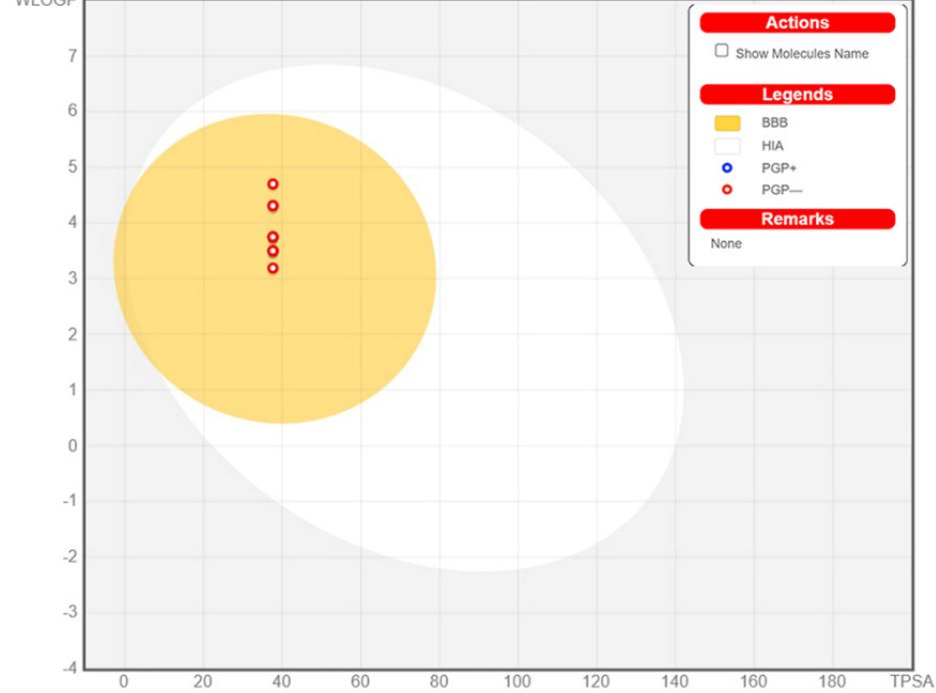
Figure 5. BOILED − Egg diagram for all designed molecules (BBB—Blood–brain barrier; PG+/ − — P − glycoprotein; HIA—human intestinal absorption).